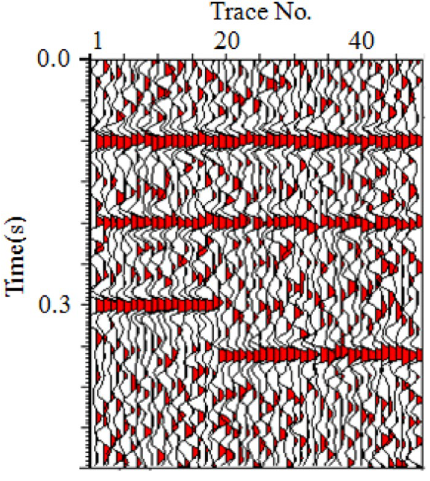
Fig. 1 Synthetic seismic data with additive Gaussian noise, the lowest reflector shows a